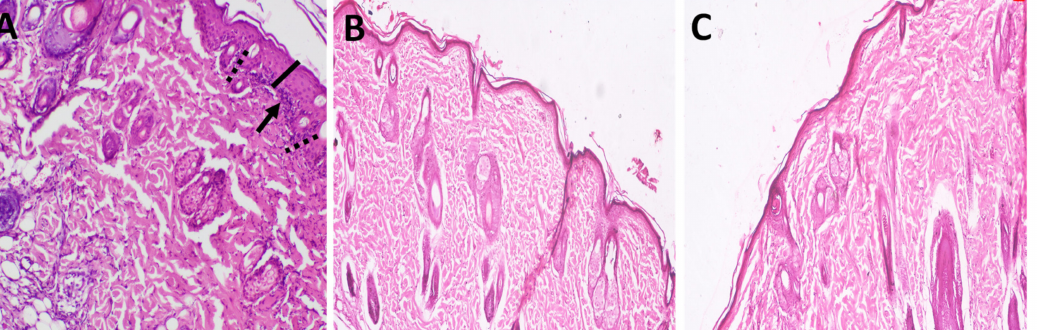
Figure 7. Representative images of H and E stained photomicrographs of skin for one representative guinea pigs after skin sensitization test for ( A ) Positive control; animals injected intradermally with skin sensitizing agent, a mixture of Freund’s Complete Adjuvant (FCA), and physiological buffered saline (PBS) (1:1 mixture, 0.1 mL) ( B ) Rhamnolipids nano-micelles solution (0.625 mg/mL) dispersed in PBS (10 mM, pH 7.4), and ( C ) Negative control; animals injected intradermally with physiological buffered saline (PBS, 0.1 mL). Positive control revealed thickening of epiderma (black line), inflammatory cells infiltration (black head arrow) and spongiosis (dashed line). ( B , C ) group revealed normal skin